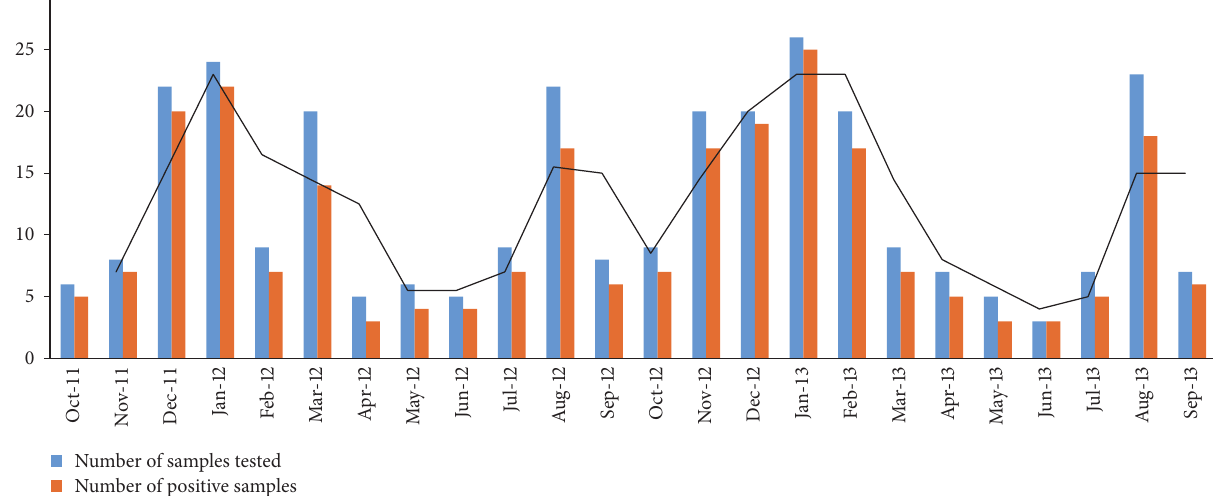
Figure 2: Month-wise recruitment of ARI cases and samples positive for